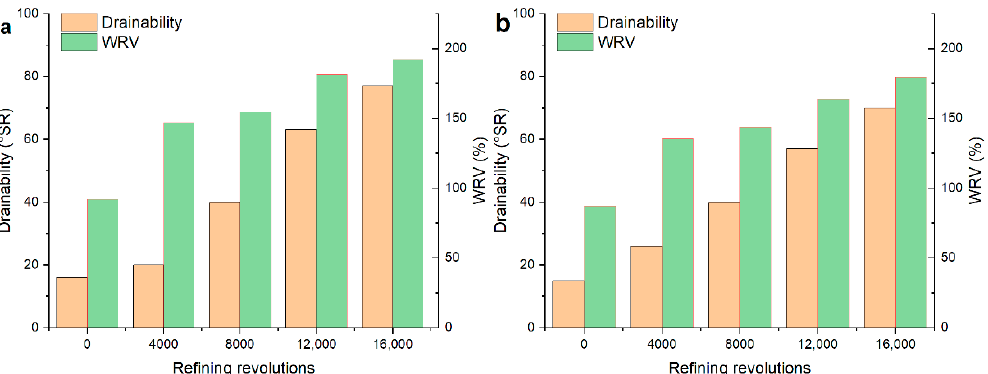
Figure 2. The beating degree and Water Retention Value (WRV) for the unrefined and refined samples: ( a ) softwood fibers and ( b ) hardwood fibers.